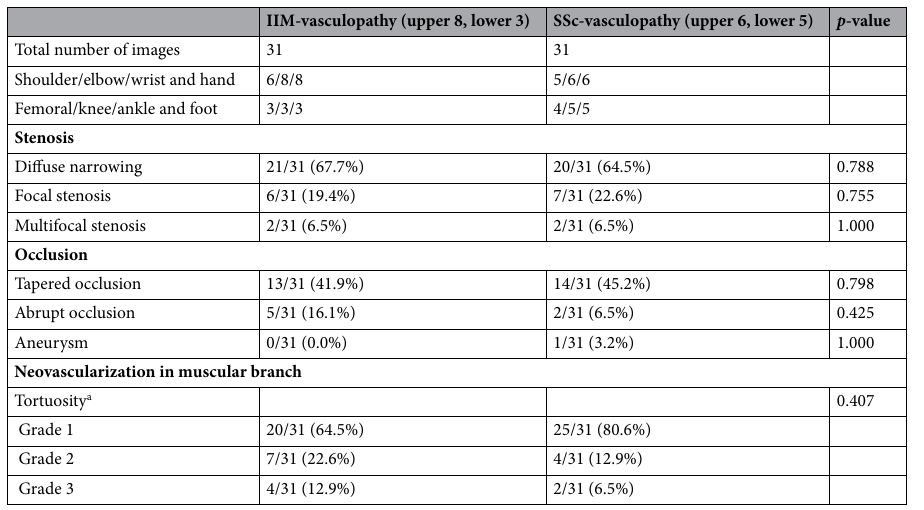
Table 3. Comparison of angiographic parameters in subgroups of IIM/SSc-vasculopathy. Data are expressed as number (%) of images. IIM idiopathic inflammatory myopathies, SSc systemic sclerosis. a Tortuosity grade 1, normal; grade 2, mild to moderate; grade 3, severe (hypertortuosity).